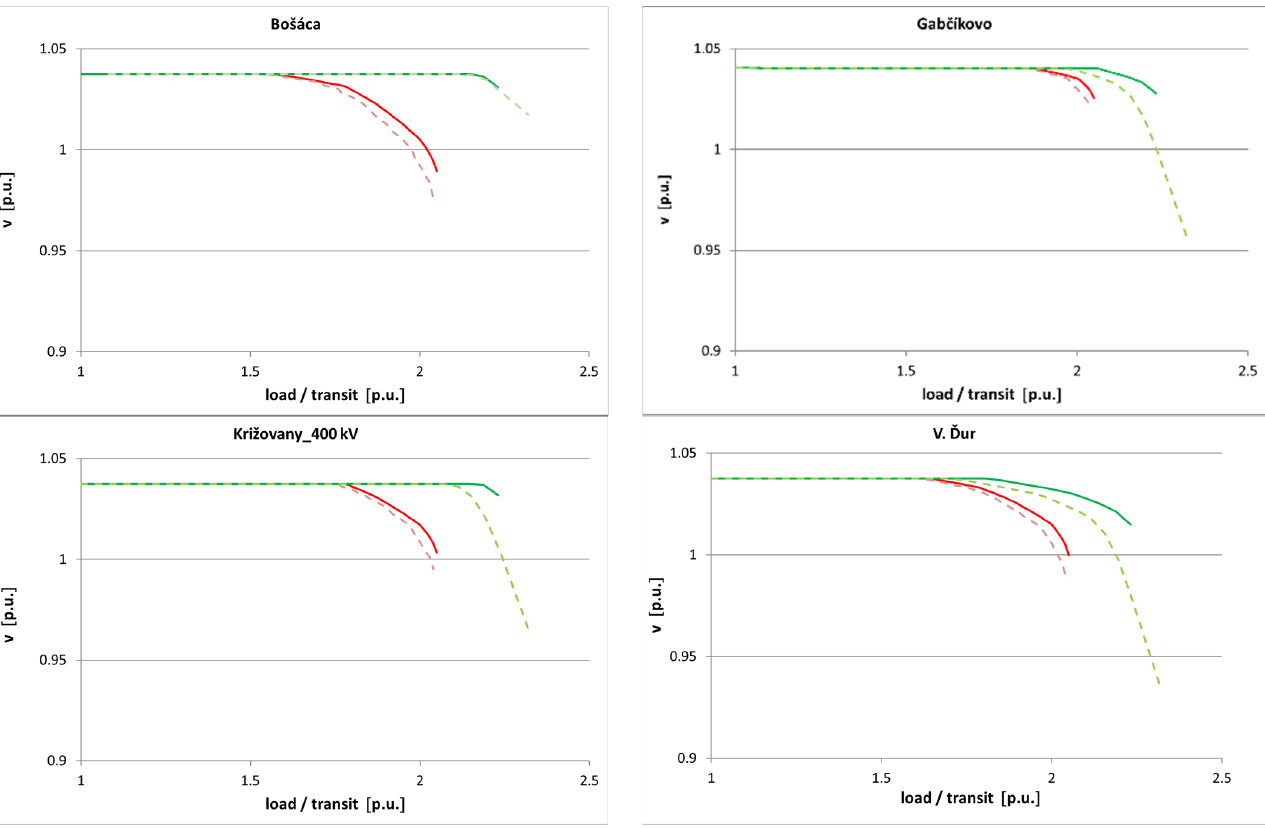
Figure 8. PV curves for the pilot nodes in the TS: winter.